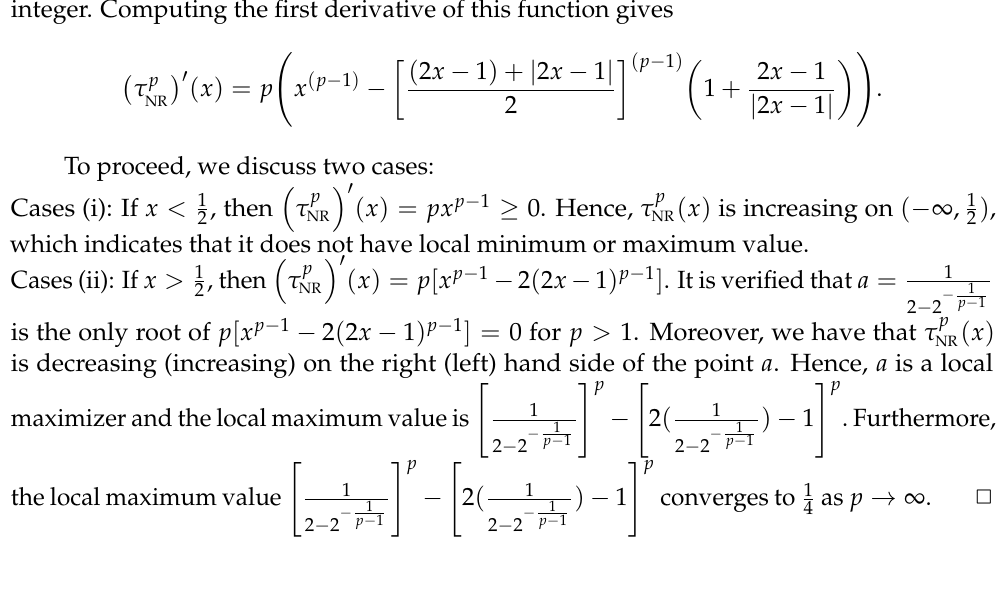
( x ) , τ p ( x ) and σ p ( x ) with different values of p . ( a ) Local minimum FB D − FB FB